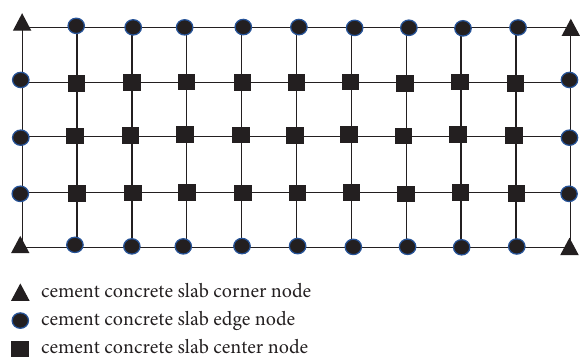
Figure 5: Schematic diagram of nodes of cement concrete slab.